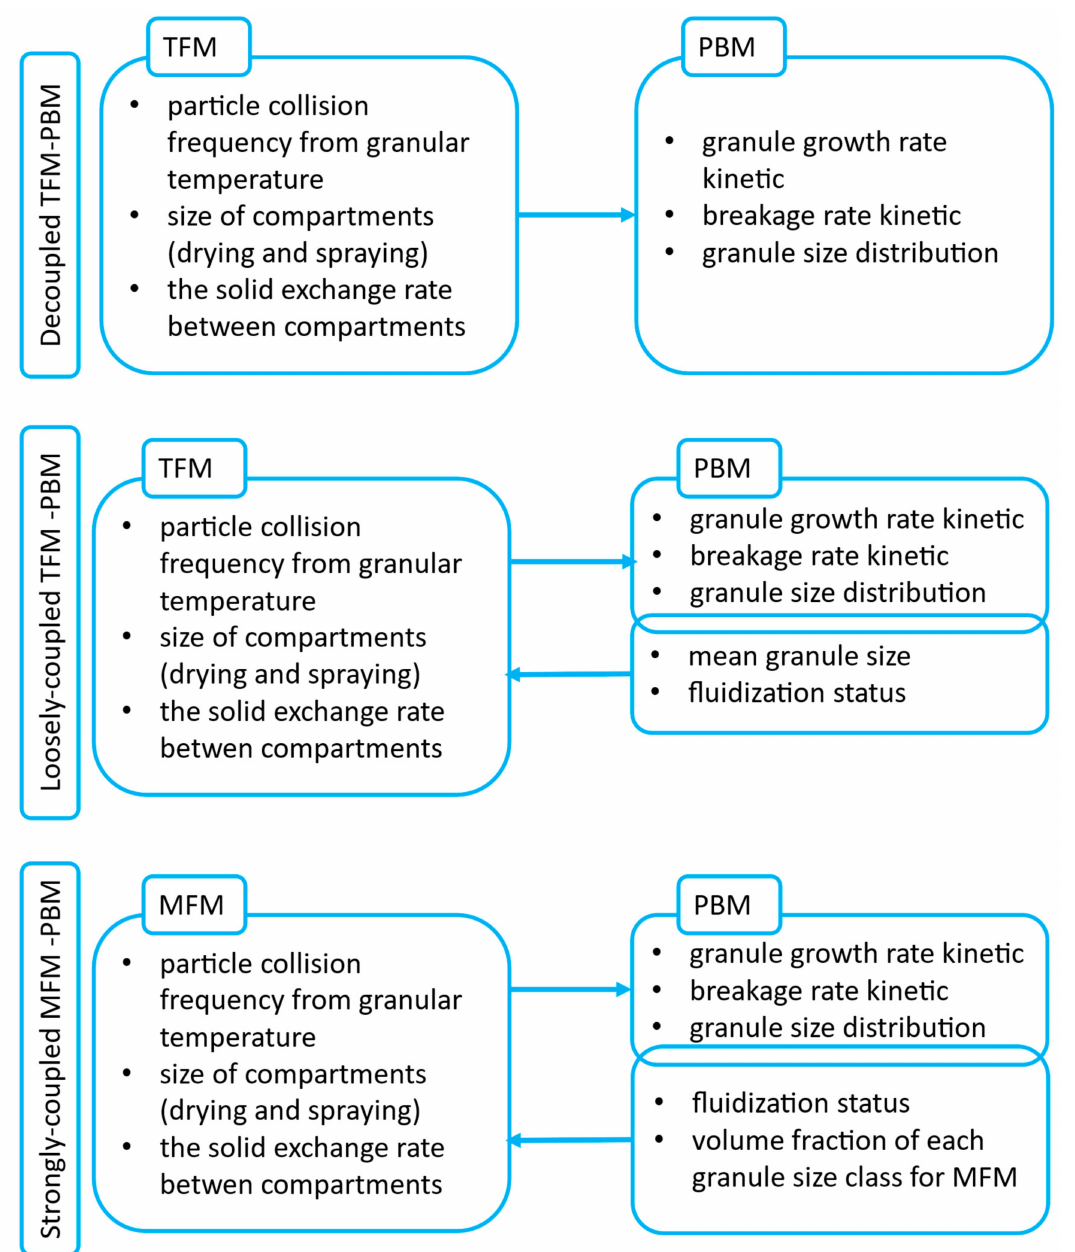
Figure 7. Information exchange between TFM/MFM and PBM approaches for different levels of coupling (MFM stands for Multi-Fluid